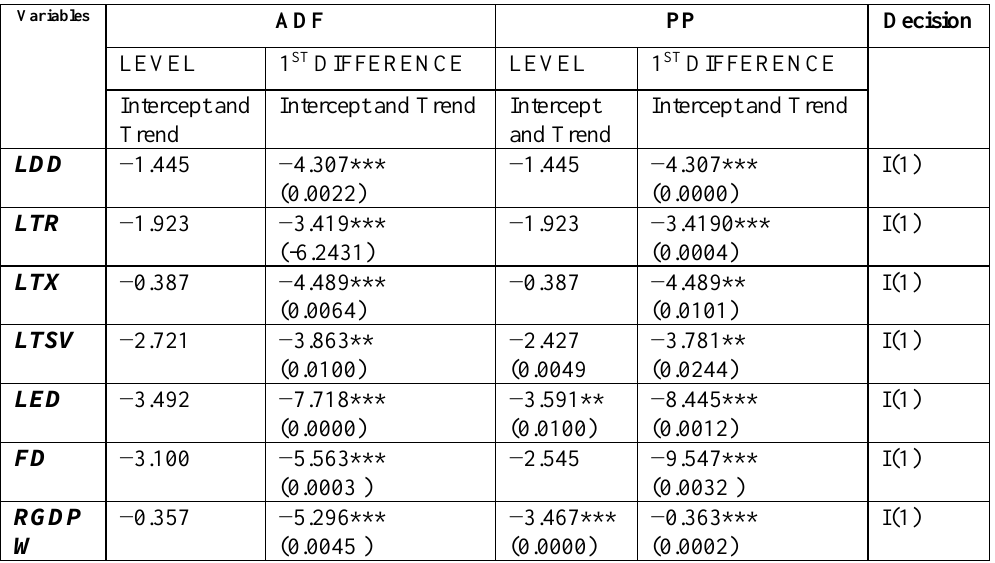
Table 2. Result of the unit root